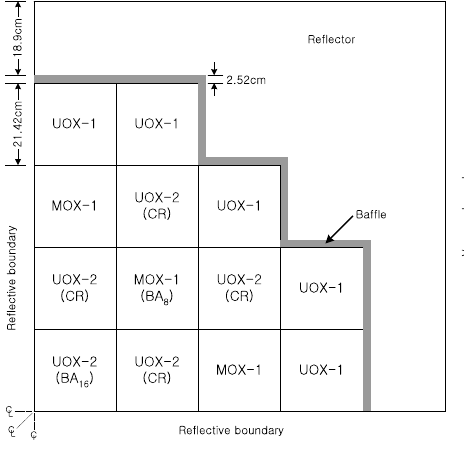
Figure 4: The KAIST 1A benchmark core layout.